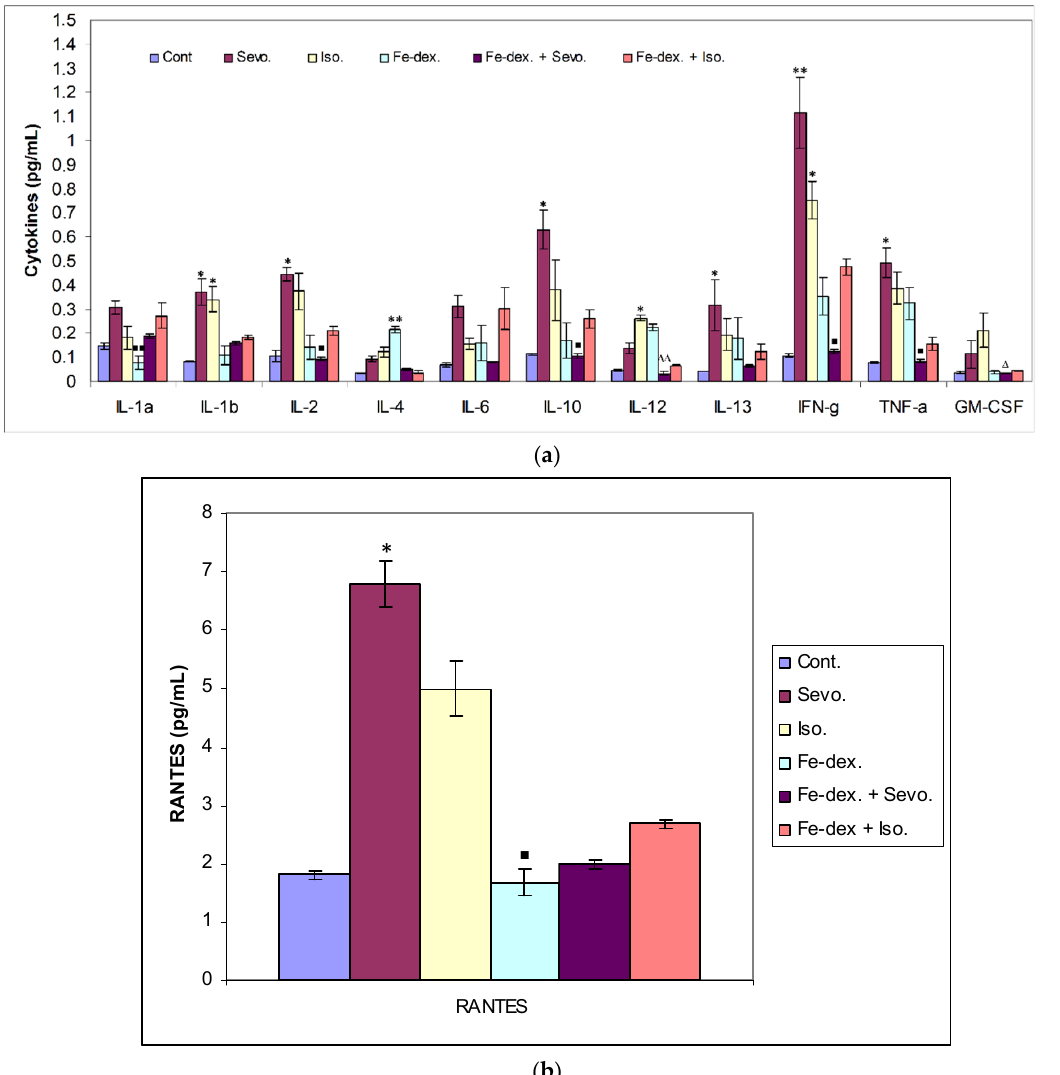
Figure 7. Effect of inhaled anesthetics and iron dextran on Th1, Th2 cytokines ( a ), and chemokine RANTES ( b ) in rats treated for 28 days. Rats ( n = 10 per group) were treated with ip injection of iron dextran (50 mg/kg), exposed to 2.4 vol % sevoflurane inhalation and 1.3 vol % isoflurane inhalation, and exposed to a combination thereof where inhaled anesthetics were given 2 h after ip injection of iron dextran. Animals were treated every other day for 28 days. The results are expressed as the mean value of each experimental group ± SE. * Statistically significant compared to the control (cid:4) (cid:4) p group (* p < 0.05; ** p < 0.01); Statistically significant compared to the sevoflurane group ( < 0.05; (cid:4)(cid:4) p < 0.01); ∆ Statistically significant compared to the isoflurane group ( ∆ p < 0.05; ∆∆ p < 0.01). Other statistically significant changes exist in: ( a ) IL-4 (pg/mL)—Fe-dex. vs. Fe-dex. + Iso. ( p < 0.05); IL-12 (pg/mL)—Fe-dex. vs. Fe-dex. + Sevo. ( p < 0.05). Abbreviations: Cont., control group; Sevo., sevoflurane group; Iso., isoflurane group; Fe-dex., iron dextran group; Fe-dex. + Sevo., group treated with iron dextran and sevoflurane; and Fe-dex. + Iso., group treated with iron dextran and